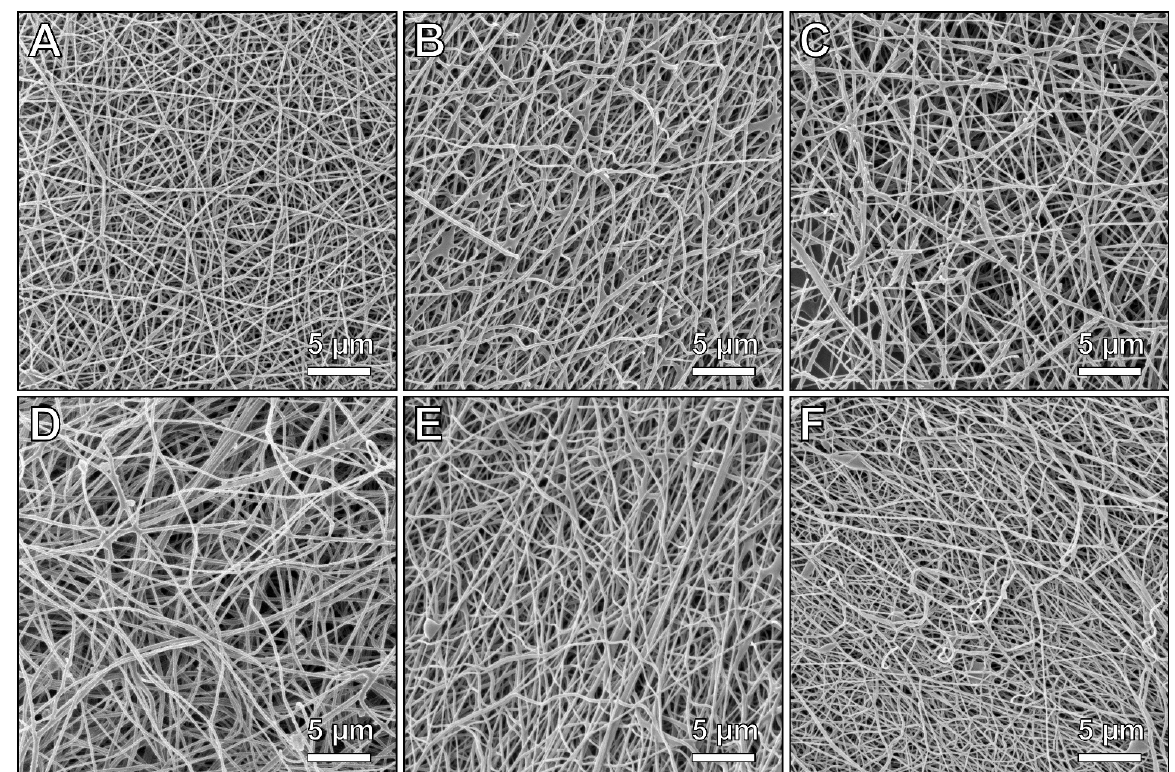
Figure 1. HIM images of PAN nanofibers with a field of view of (30 µm) 2 : ( A ) PP-E, ( B ) PP-C, ( C ) AL-C, ( D ) AL-SW1-C, ( E ) AL-SW2-C, and ( F ) STS-SW-C. Overview images with a field of view of (150 µm) 2 , including an image of sample AL-E, are shown in Figure S1 in the Supporting Information.